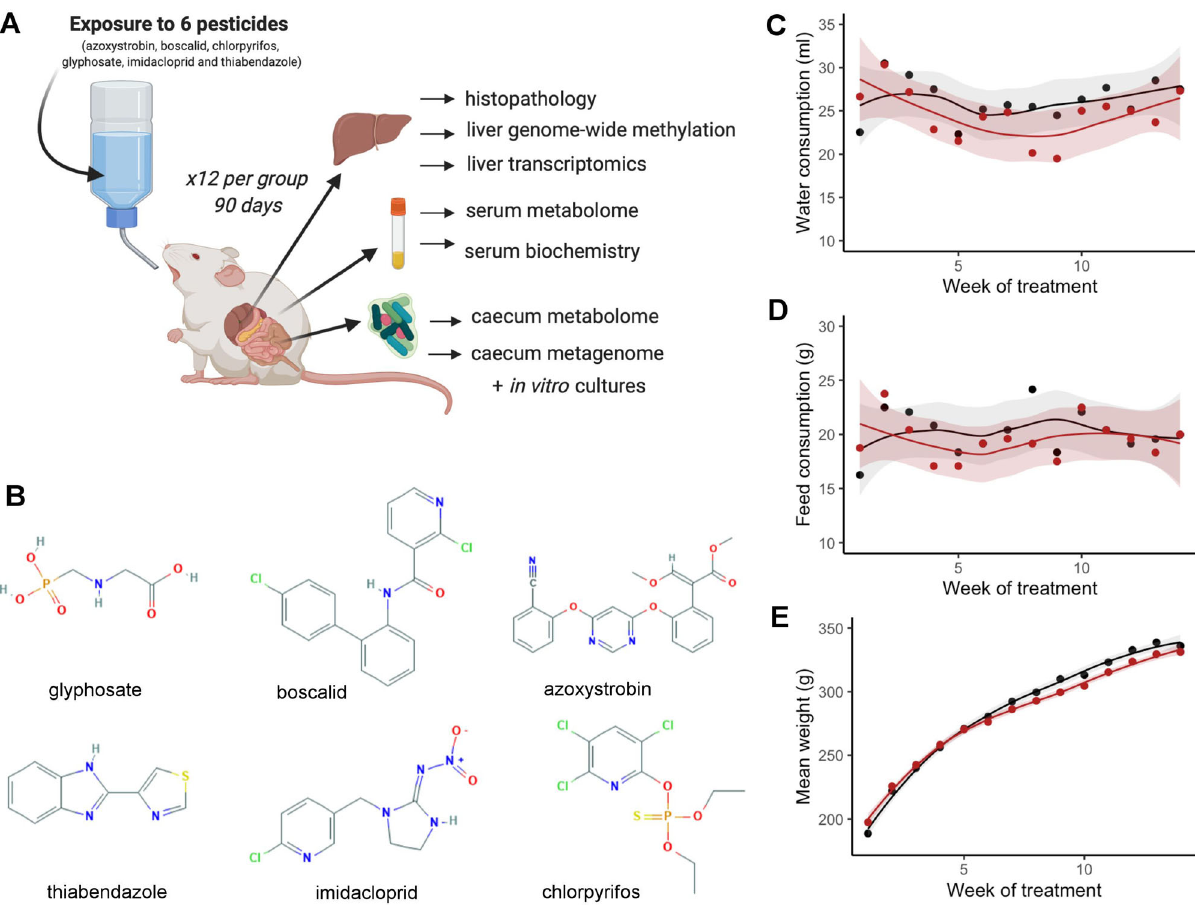
Fig. 1 General toxicity assessment of a mixture of glyphosate, azoxystrobin, boscalid, chlorpyrifos, imidacloprid and thiabenzadole at their acceptable daily intake in Sprague – Dawley rats. A Study design. Groups of 12 female rats were administered via drinking water with a mixture of six pesticides at the EU ADI for 90 days. Analyses following sacri fi ce are also shown (illustration created with BioRender.com). B Molecular structures of pesticide active ingredients tested. (Chemical structure from pubchem.com). Water consumption ( C ), feed consumption ( D ) and body weights with their 95% con fi dence interval band ( E ) remained unchanged (controls, black; pesticide-exposed,